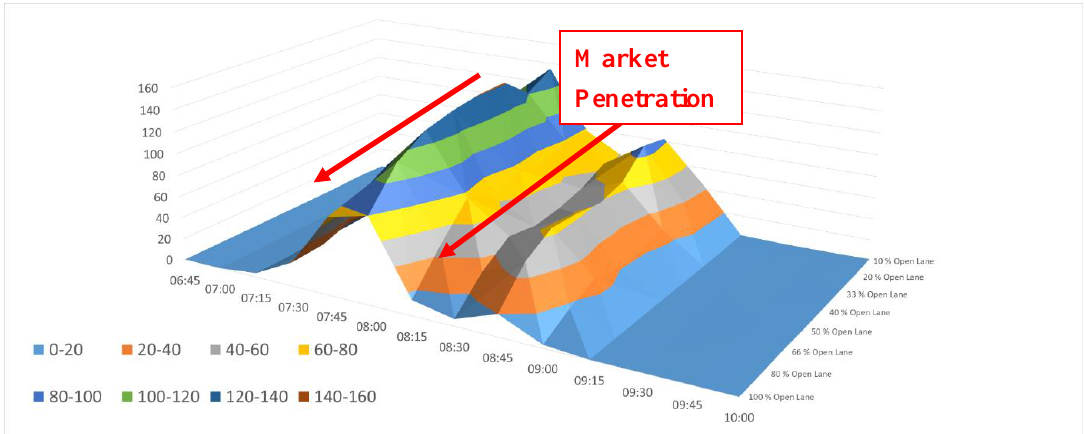
Figure 9. Time in queue (s) on the open lane .